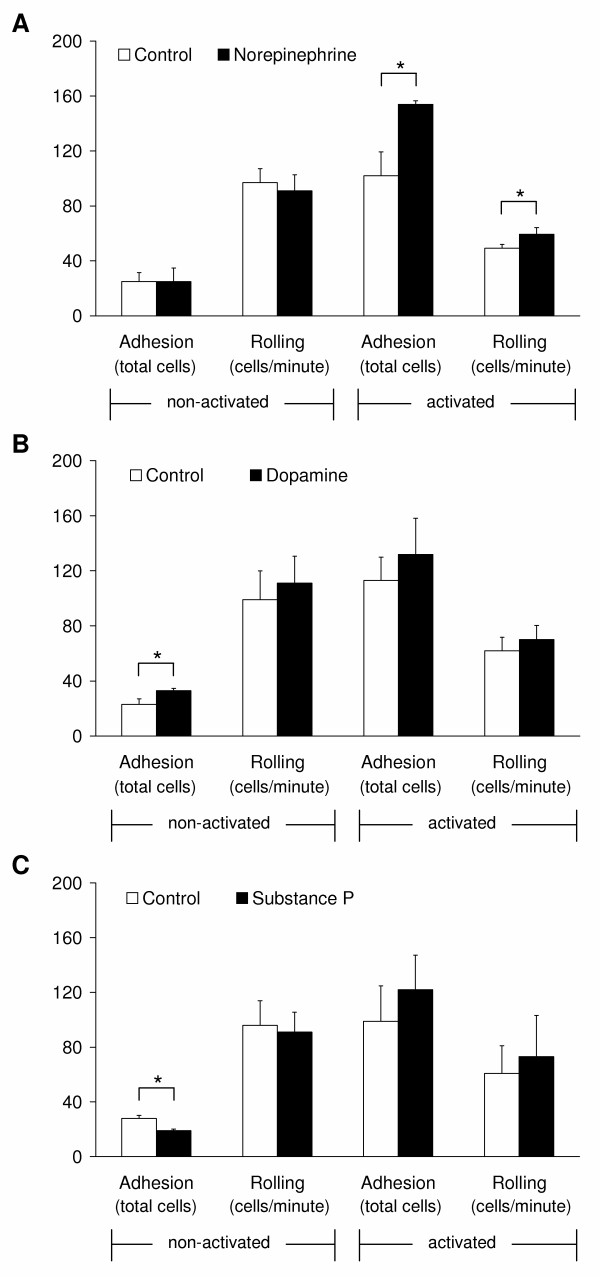
Interaction of CD8+ T lymphocytes with endothelial cells in a flow-through extravasation assay. The left columns of each graph show the adhesion and rolling of non-activated cells, the right columns show the adhesion and rolling of activated cells. "Adhesion" is the total number of tightly adherent cells in a 20 minute observation period. "Rolling" is the number of cells per minute, which rolled on the endothelium before they either tightly adhered or were washed away. Graphs show mean values and standard deviation of three independent experiments for each neurotransmitter: (A) 10 μM norepinephrine, (B) 1 μM dopamine, and (C) 1 μM substance P. Asterisks mark statistically significant changes (p < 0.05).